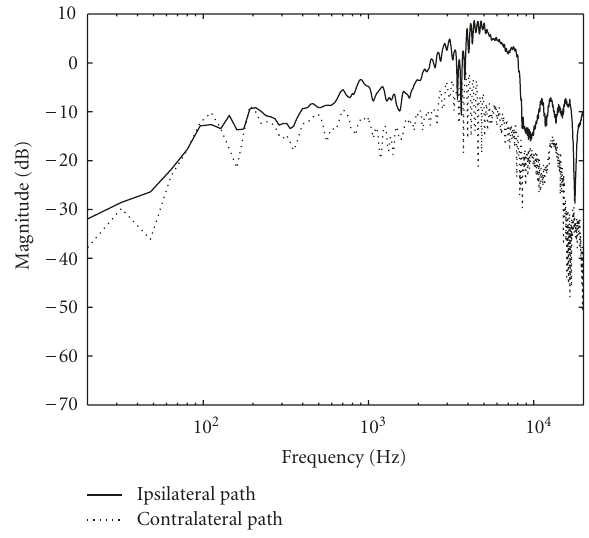
Figure 3: The frequency responses of the plants including ipsilateral and contralateral